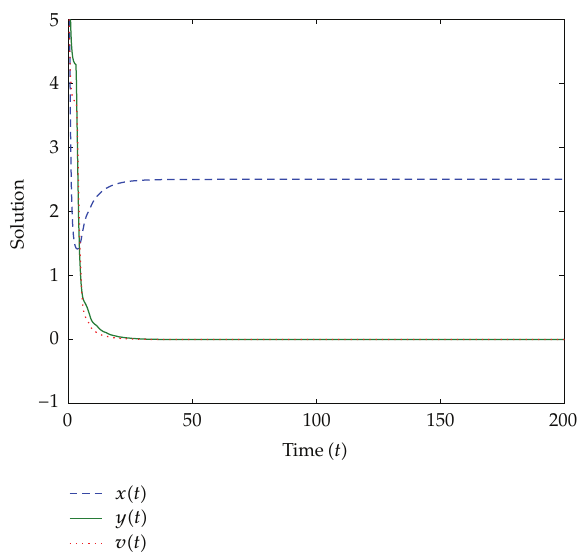
Figure 2: The numerical solution of system (cid:3) 1.4 (cid:6) when α (cid:8) 1, β (cid:8) 1, λ (cid:8) 2 . 5, a (cid:8) 2, d (cid:8) 1, k (cid:8) 1, u (cid:8) 2, τ (cid:8) 3, and (cid:3) φ 1 ,φ 2 ,φ 3 (cid:6) (cid:8) (cid:3) 10 , 8 , 6 (cid:6)